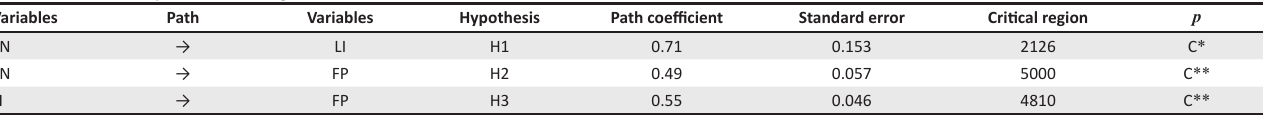
TABLE 6: Structural equation modelling results. Variables Path